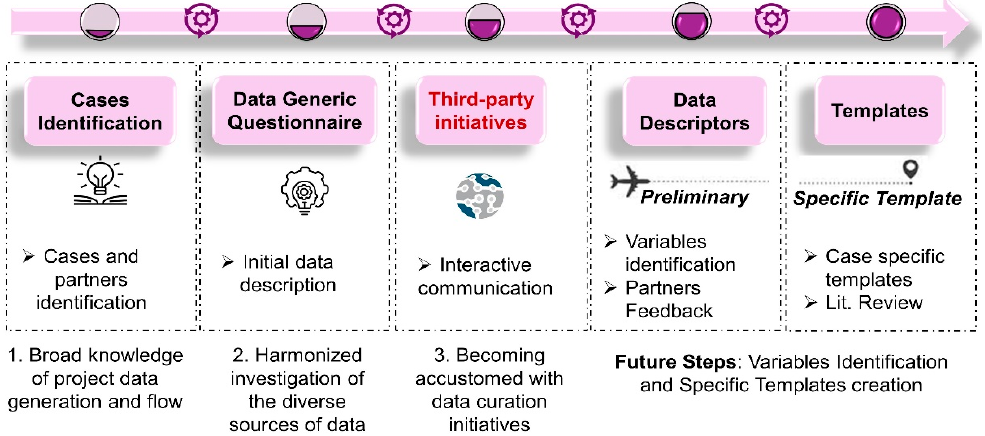
Figure 1. General workflow. Roadmap to final templates creation to be FAIRified for fit-on-purpose-specific cases.